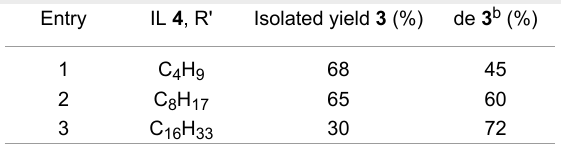
Table 2: Asymmetric aza-Diels-Alder reaction of Danishefsky's diene 1 with imine 2 (R = Ph) in the presence of chiral IL 4 (R', X = OH, Y